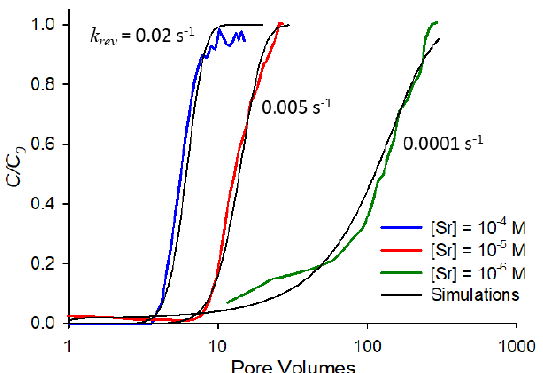
Figure 5. Experimental and simulated saturated breakthrough curves at pH 9, ionic strength 0.01 M NaNO 3 for strontium at concentrations of 10 − 4 M, 10 − 5 M, and 10 − 6 M. Simulations were fit to experimental curves by using measured R f values (Table 1) and adjusting the desorption rate constant (k rev ) values.